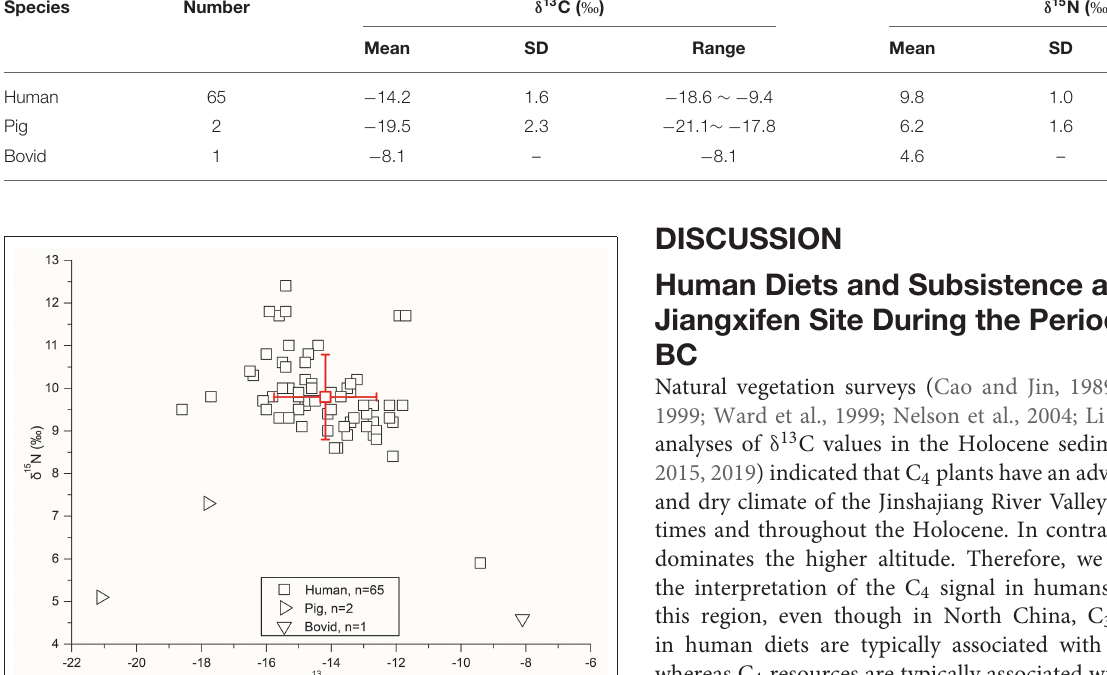
TABLE 2 | Summary of results of C and N isotopes for humans and animals at the Jiangxifen site. Species